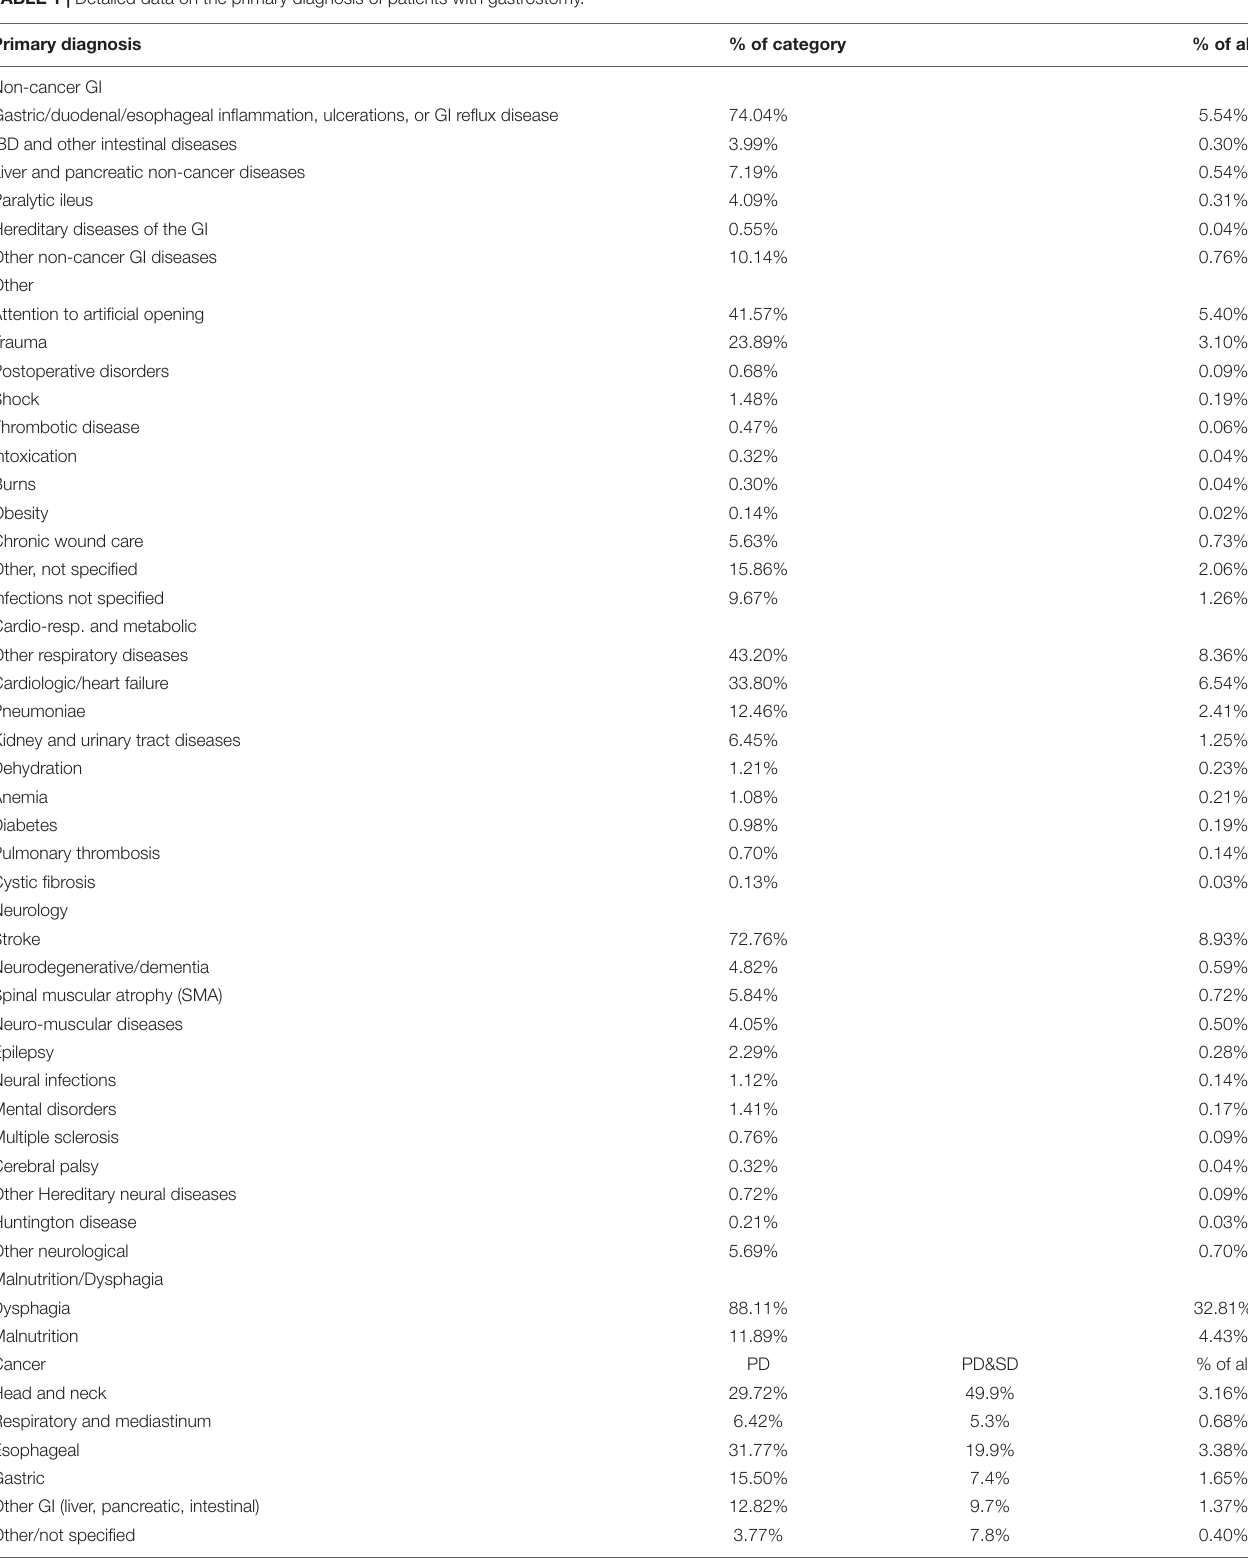
TABLE 1 | Detailed data on the primary diagnosis of patients with gastrostomy. Primary diagnosis % of category % of